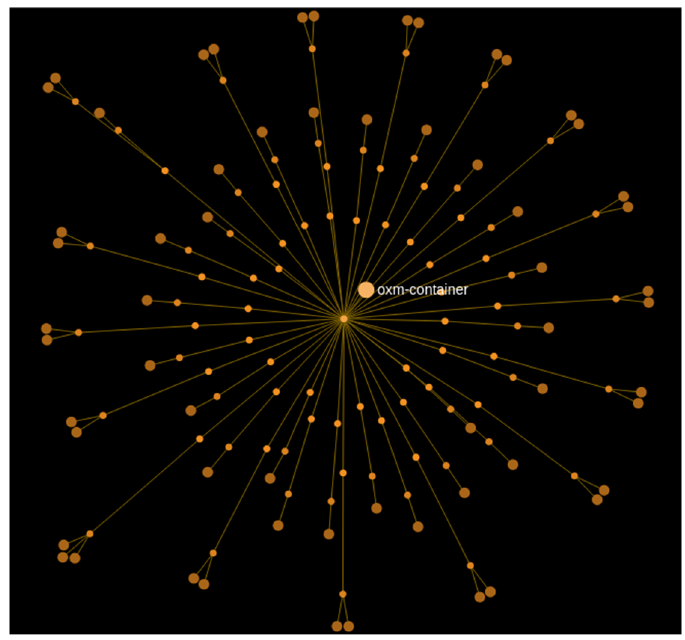
Figure 25. Model is network topology on yang ‐ visualizer on DLUX console.